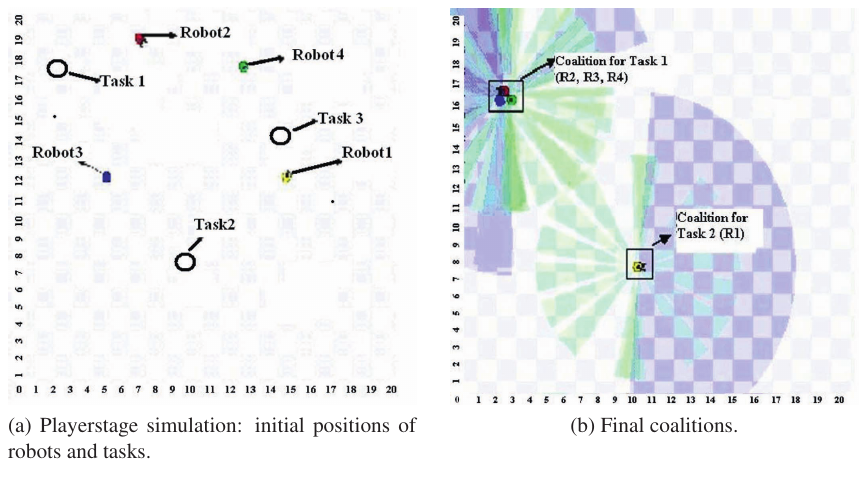
Figure 3. Robot simulations using